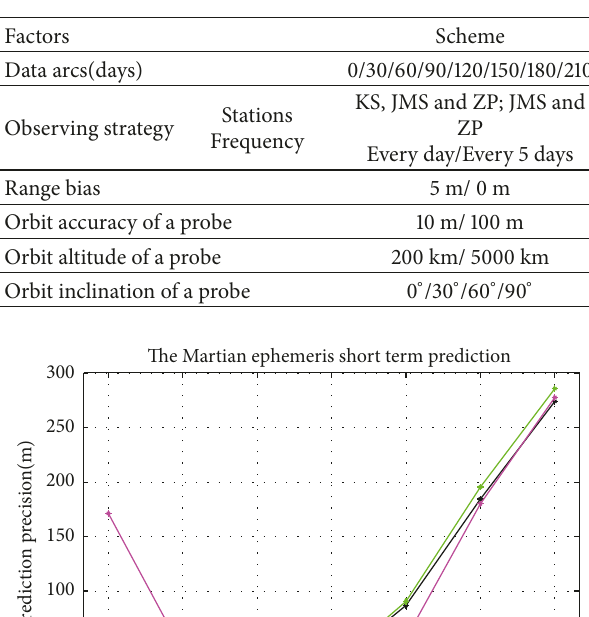
Table 4: Factors affecting the short-term prediction of the Martian ephemeris.